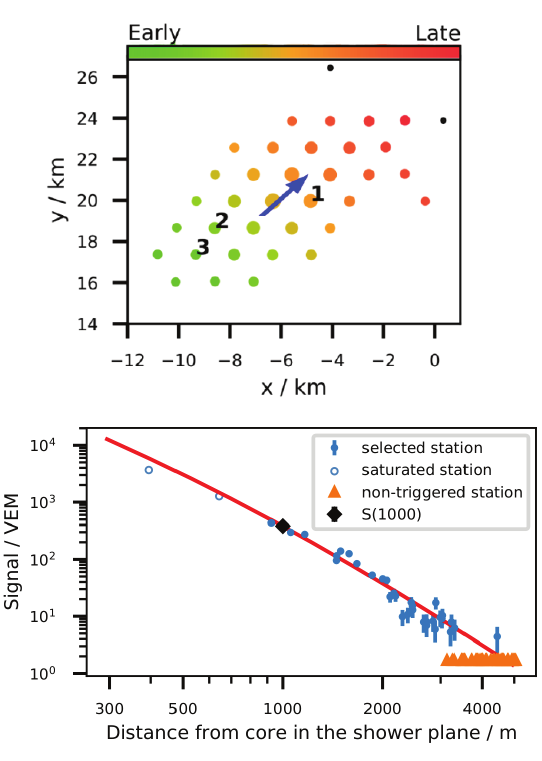
shower detected at the Pierre Auger Observatory, PAO191110 (#1), with 34 WCDs triggered. Black dots correspond to stations that were triggered randomly. Bottom : The lateral distribution function of the same event. Open circles indicate saturated sta-